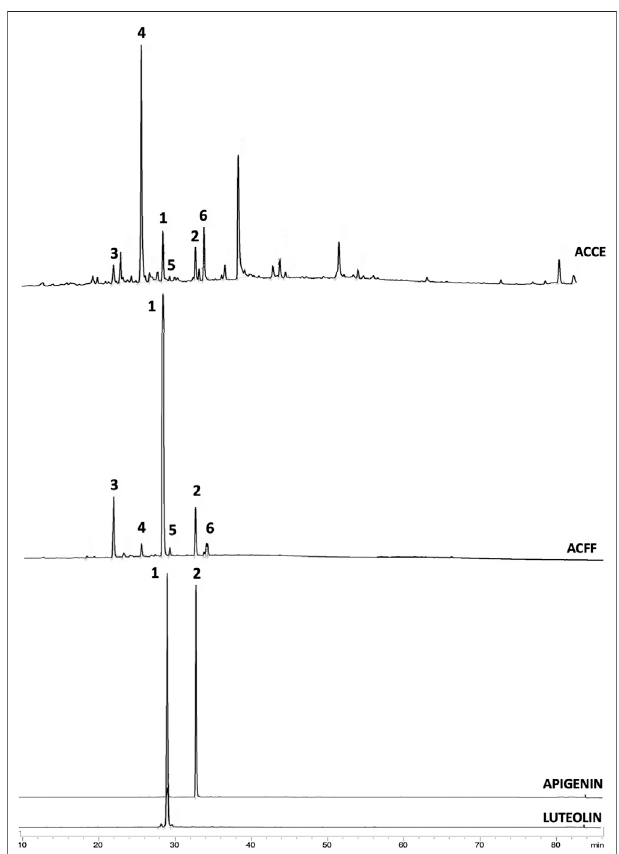
FIGURE 1 | Chromatograms obtained from HPLC-DAD-UV analysis of (A) . Arrabidaea chica crude extract (ACCE) showing all peaks including non- fl avone compounds; (B) . A. chica fl avone-rich fraction (ACFF) showing 6 peaks identi fi ed as fl avones: luteolin ( 1 ), apigenin ( 2 ), 6-hydroxy-luteolin ( 3 ), scutellarein ( 4 ), caraju fl avone ( 5 ) and chrysoeriol ( 6 ); (C) . luteolin (Rt (cid:2) 29.34 min); (D) . Apigenin (Rt (cid:2) 33.67 min).